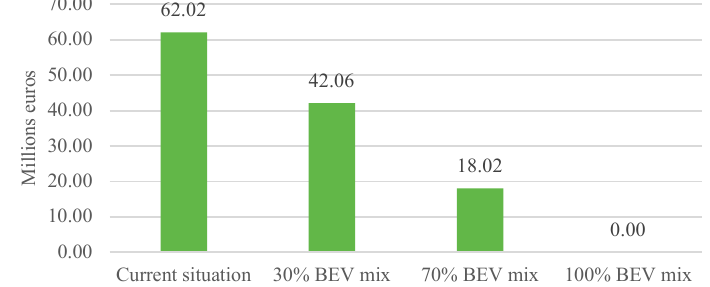
Fig. 2. Yearly climate change external costs with different BEV proportions in Latvia’s passenger car and LCV